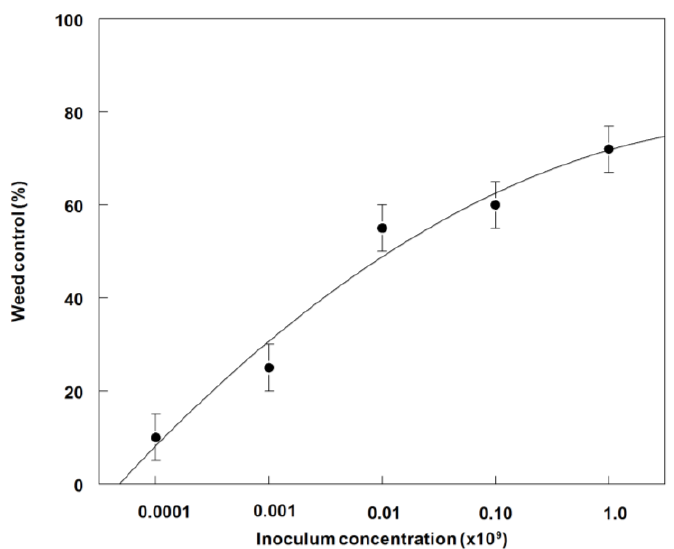
Figure 9. Effect of P. commelinicola inoculum concentration on the control of C. diffusa in the cotyledonary to third leaf growth stage under field conditions.